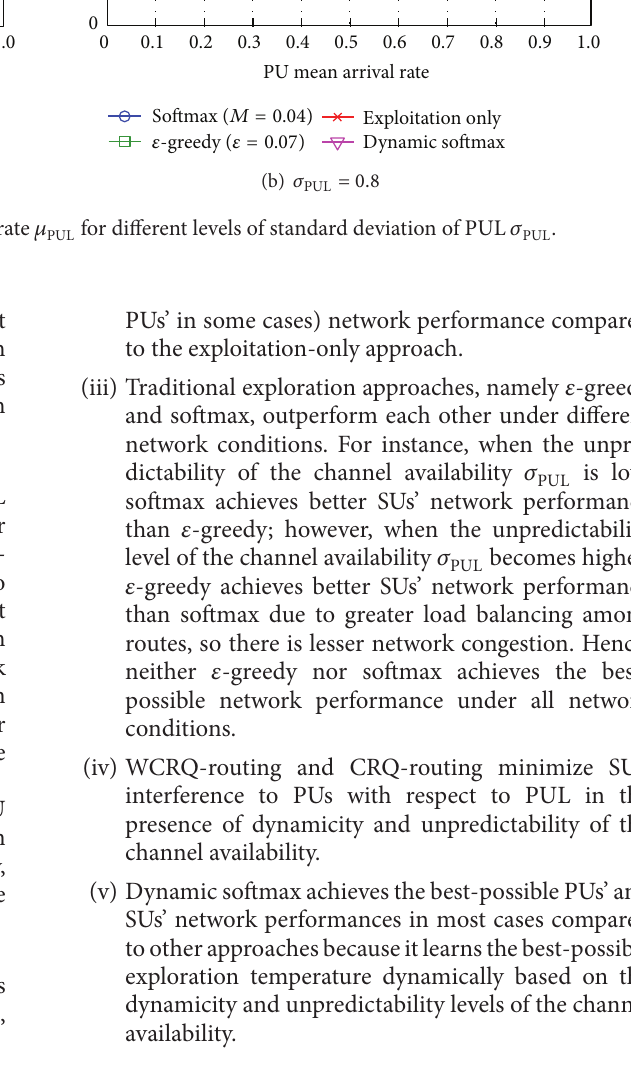
Figure 14: SU throughput for varying PU mean arrival rate 𝜇